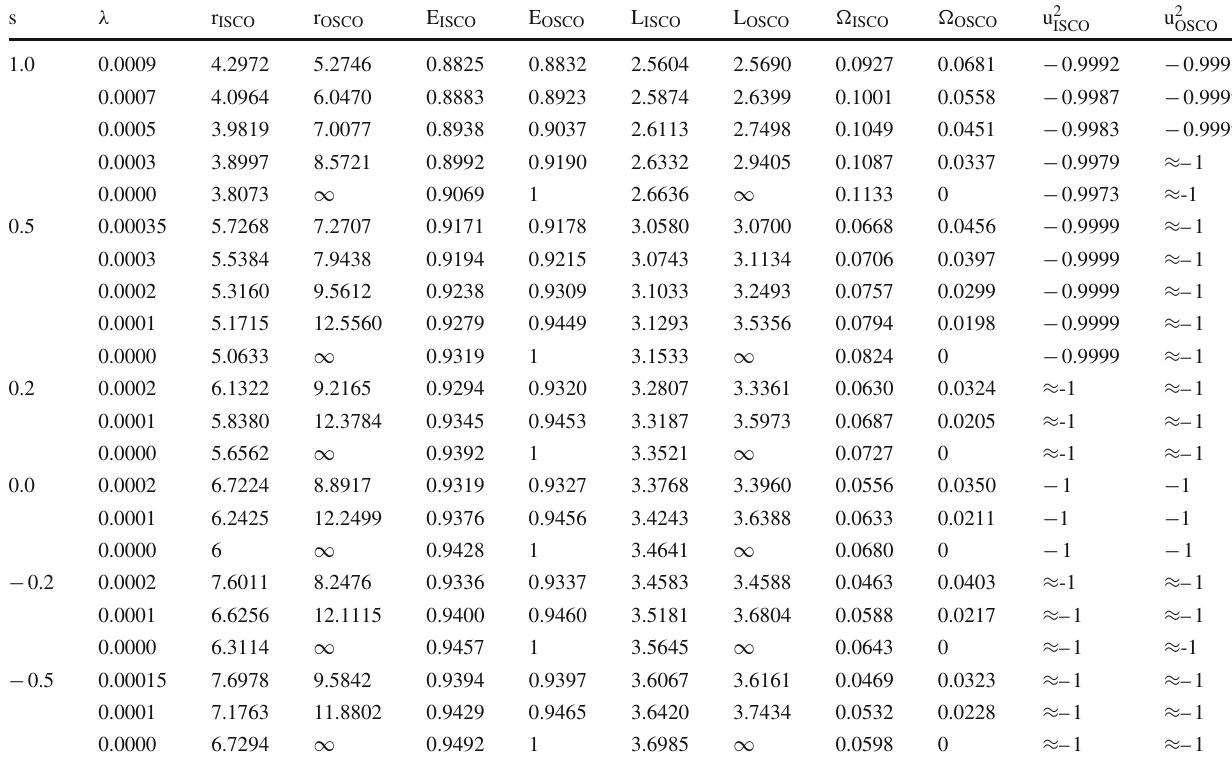
Table 2 Values of the characteristic parameters of spinning particles at ISCO and OSCO of the Schwarzschild–de Sitter black